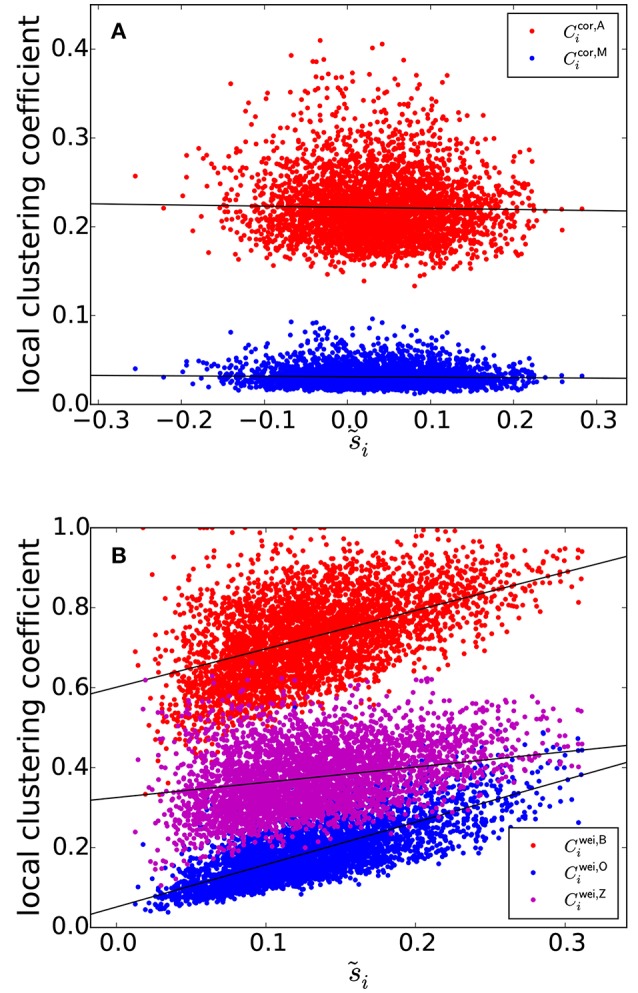
(A) Relationship between s~i and the local clustering coefficients for correlation matrices. (B) Relationship between s~i and the local clustering coefficients for weighted networks. The solid lines represent the fixed effect estimated by the linear mixed model.